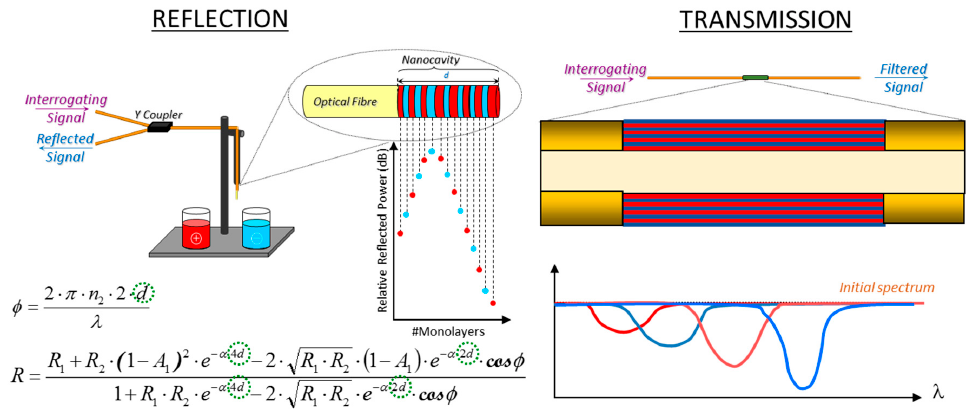
Figure 11. Mechanisms to control the nanocoatings growing for reflection and transmissions configurations: the first one is based on interferometry whereas the second on LMRs.